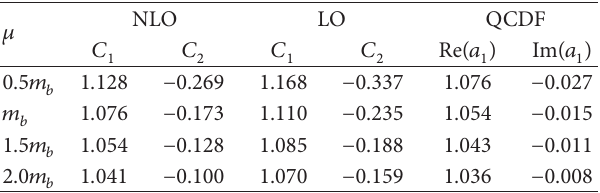
Table 2: The numerical values of the Wilson coefficients 𝐶 1 , 2 and 𝑎 1 for the Υ( 1 𝑆) → 𝐵 𝑐 𝜋 decay at different scales, where 𝑚 𝑏 = 4.78 GeV